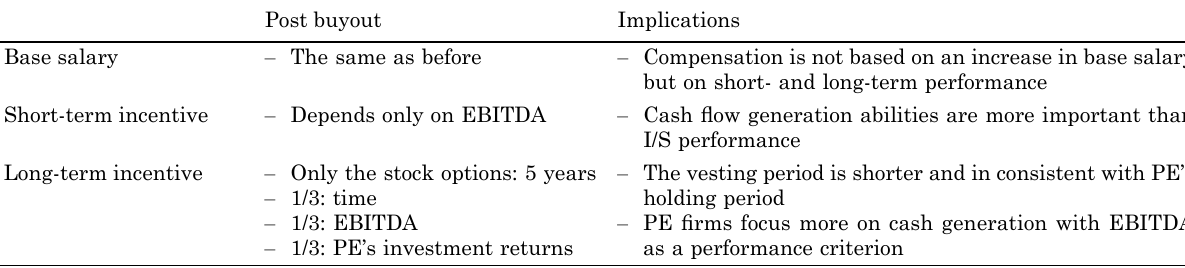
Table 2. HCA’s incentive program and its implications in